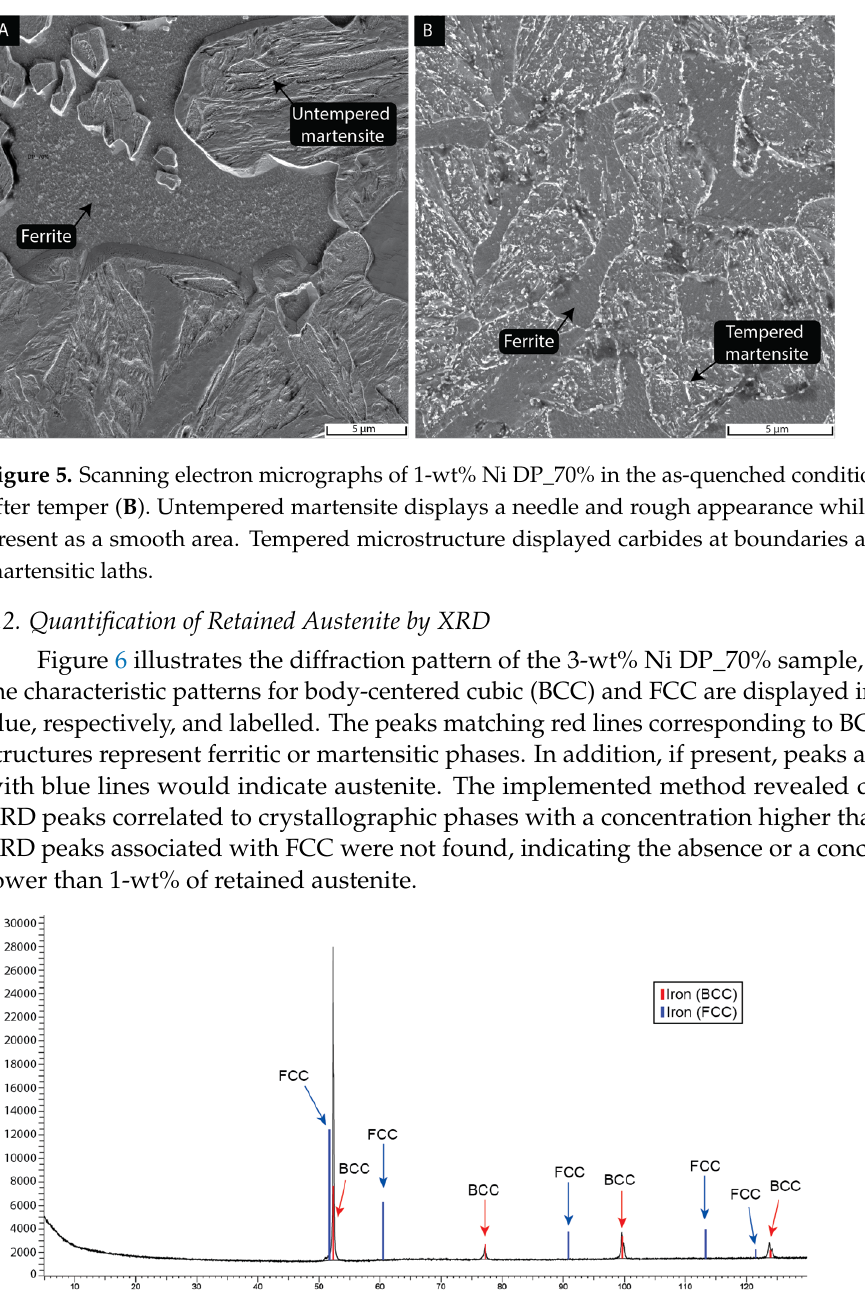
Figure 7. Ferrite grain size characterization by EBSD for varying content of martensite and Ni. Refining effect evident when increasing Ni content to 3-wt% Ni. 3.3. Mechanical characterisation Representative engineering tensile stress–strain curves of 0, 1, and 3-wt% Ni DP-LAS with a martensite content of approximately 50% are summarized in Figure 8A.